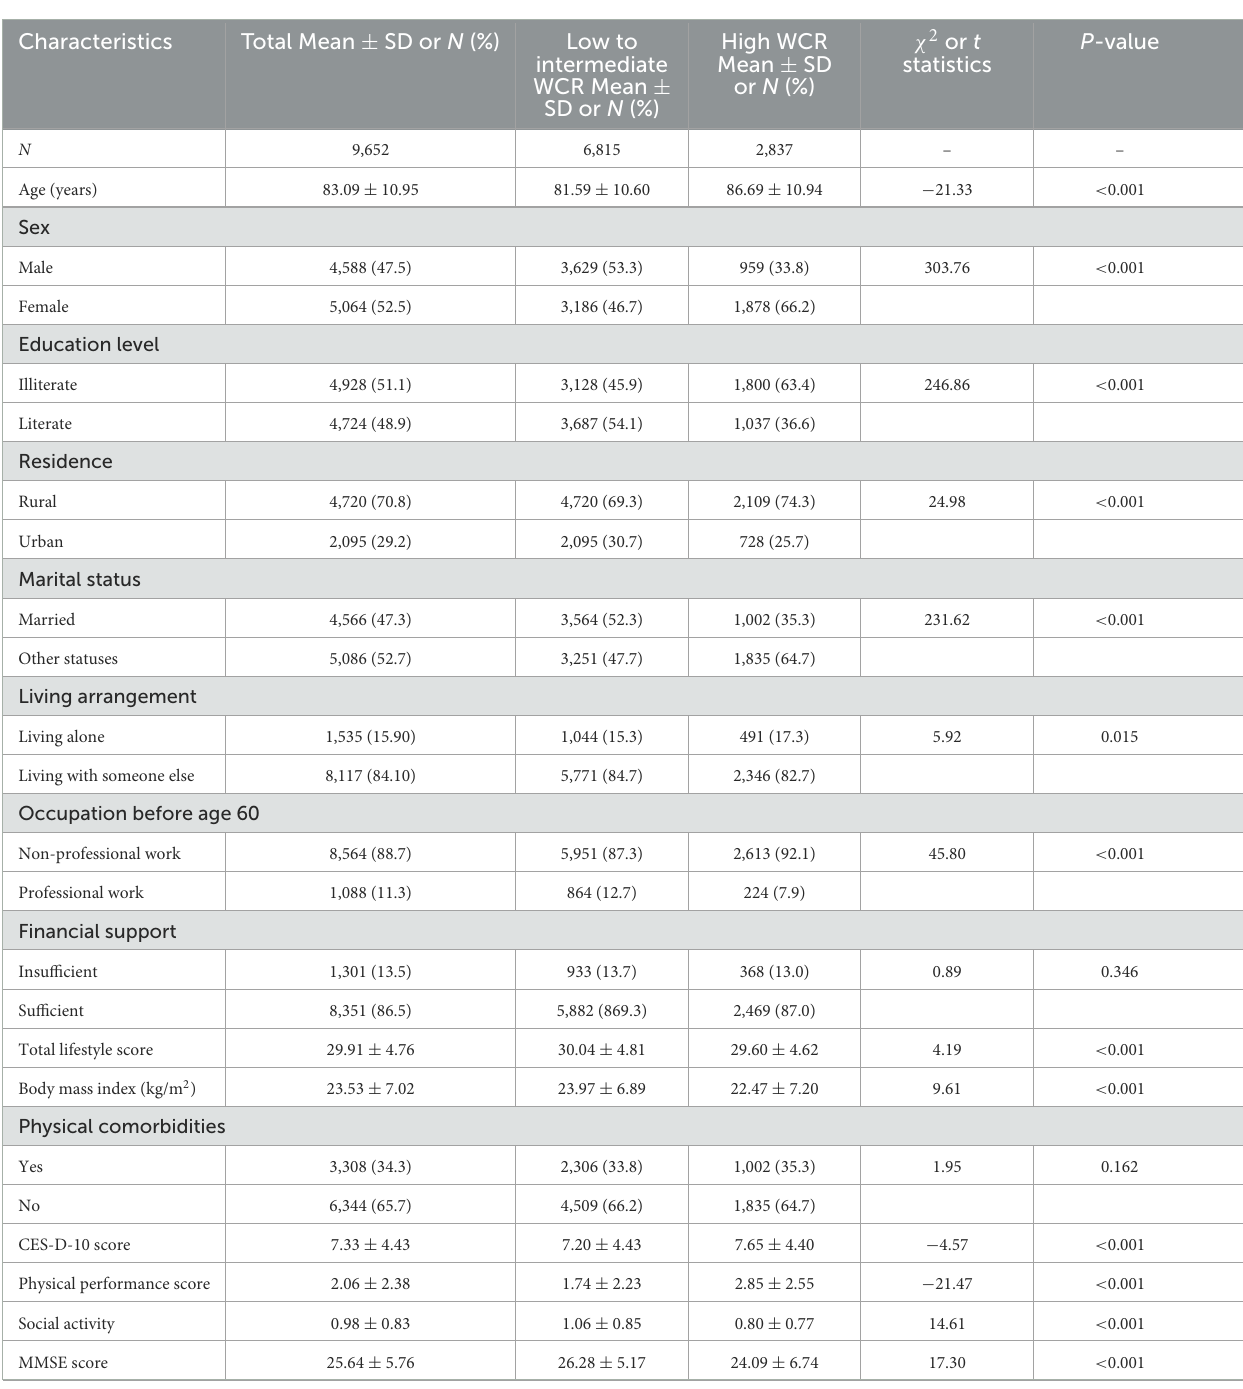
TABLE 1 Characteristics of the sample stratified by waist-to-calf circumstance ratio (WCR).